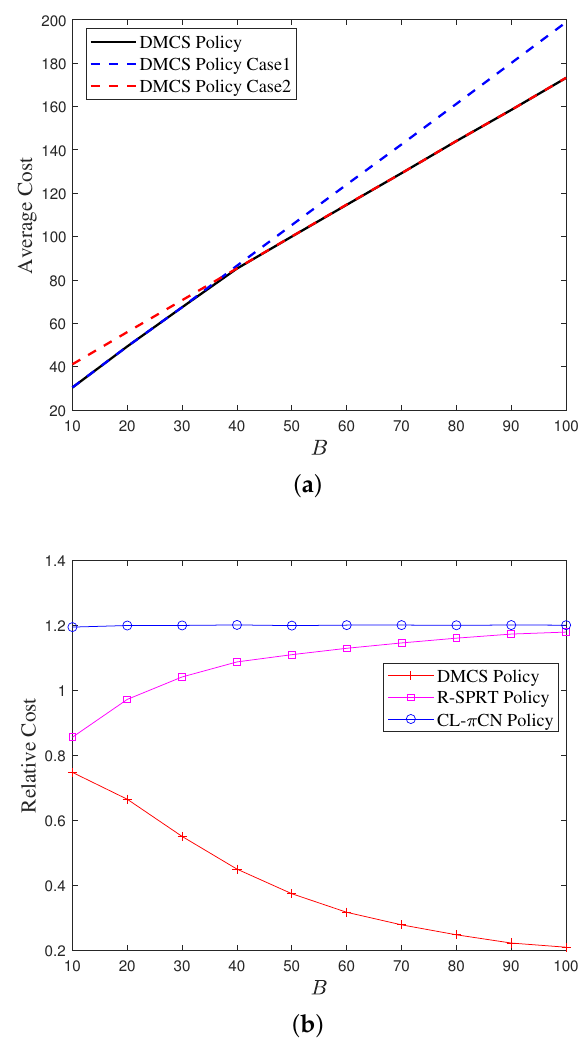
Figure 2. Performance comparison for M = 5, L = 2, s = 2, λ f = 2, λ g = 0.01. ( a ) Average cost under DMSC policy. ( b ) Relative cost under the DMSC policy, the Sequential Probability Ratio Testing policy (R-SPRT) and CL- π cN policy as compared to the asymptotic lower bound. L DMSC approaches 0 as B → ∞ ( α → 0